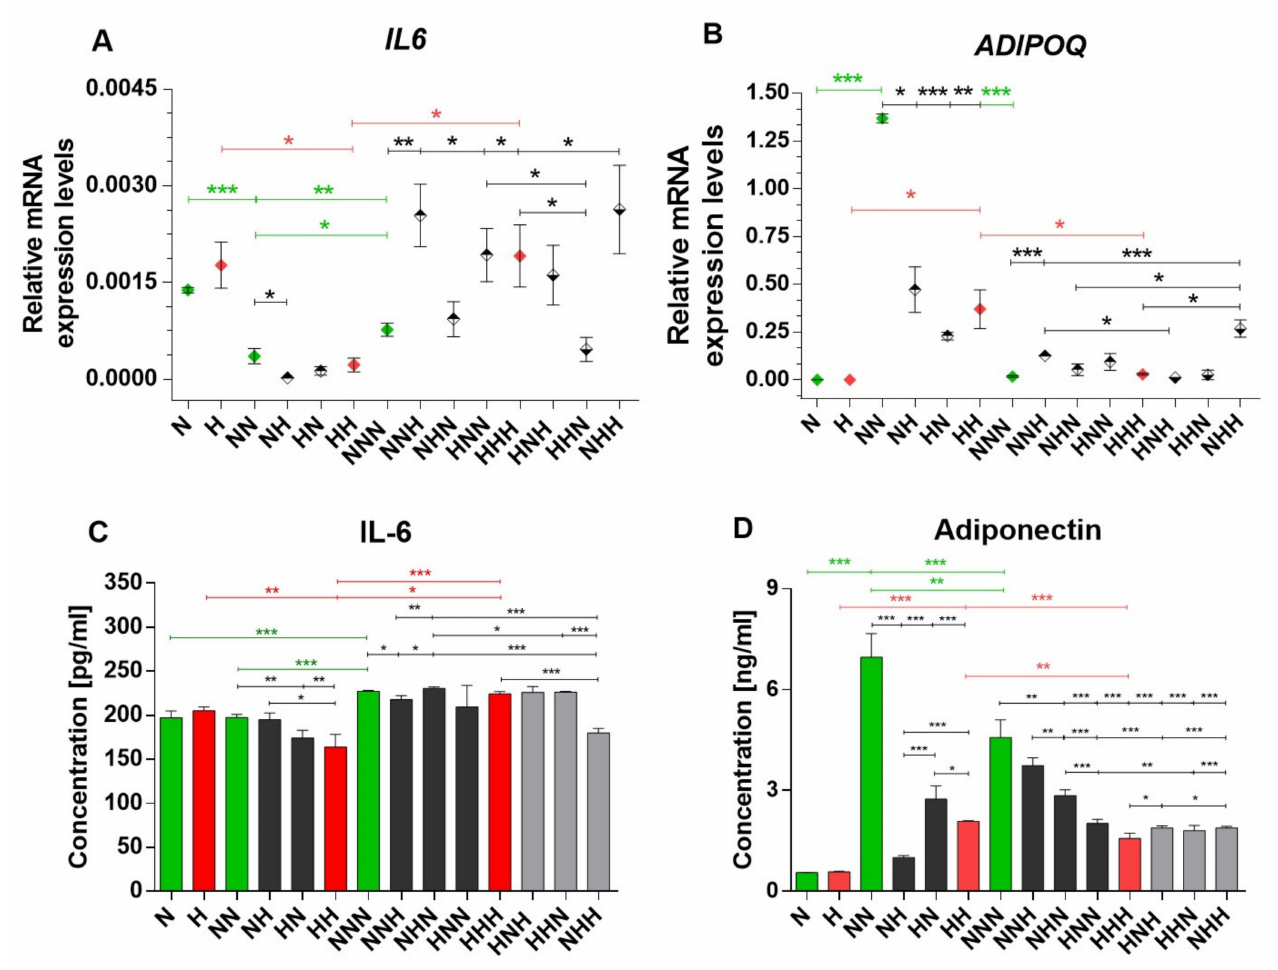
Figure 2. Expression of IL6 ( A ), ADIPOQ ( B ), mRNAs and IL-6 ( C ), and APN ( D ) proteins in studied human visceral preadipocytes (HPA-vs). Variants differentiated chronically in normoglycemic conditions and chronic hyperglycemia (HG) are colored in green and red (rhombuses or bars), respectively. In Figure 2A,B, variants of transient HG treatment applied during one stage of cell culture are marked by rhombuses with a black upper half and variants exposed to HG during two stages are denoted as rhombuses with a black lower half. In Figure 2C,D, variants of transient HG treatment applied during one stage of cell culture are denoted by black bars and variants exposed to HG during two stages are denoted by grey bars. Data are presented as mean ± SEM. Significant differences are marked by asterisks according to the p -value criteria: *—0.05 ≥ p > 0.01, **—0.01 ≥ p > 0.001, ***— p ≤ 0.001. Significant differences estimated in one-way ANOVA with a post-hoc Tukey test are marked by green or red